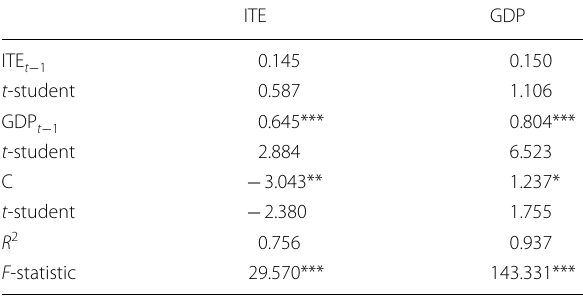
Table 7 VAR estimation